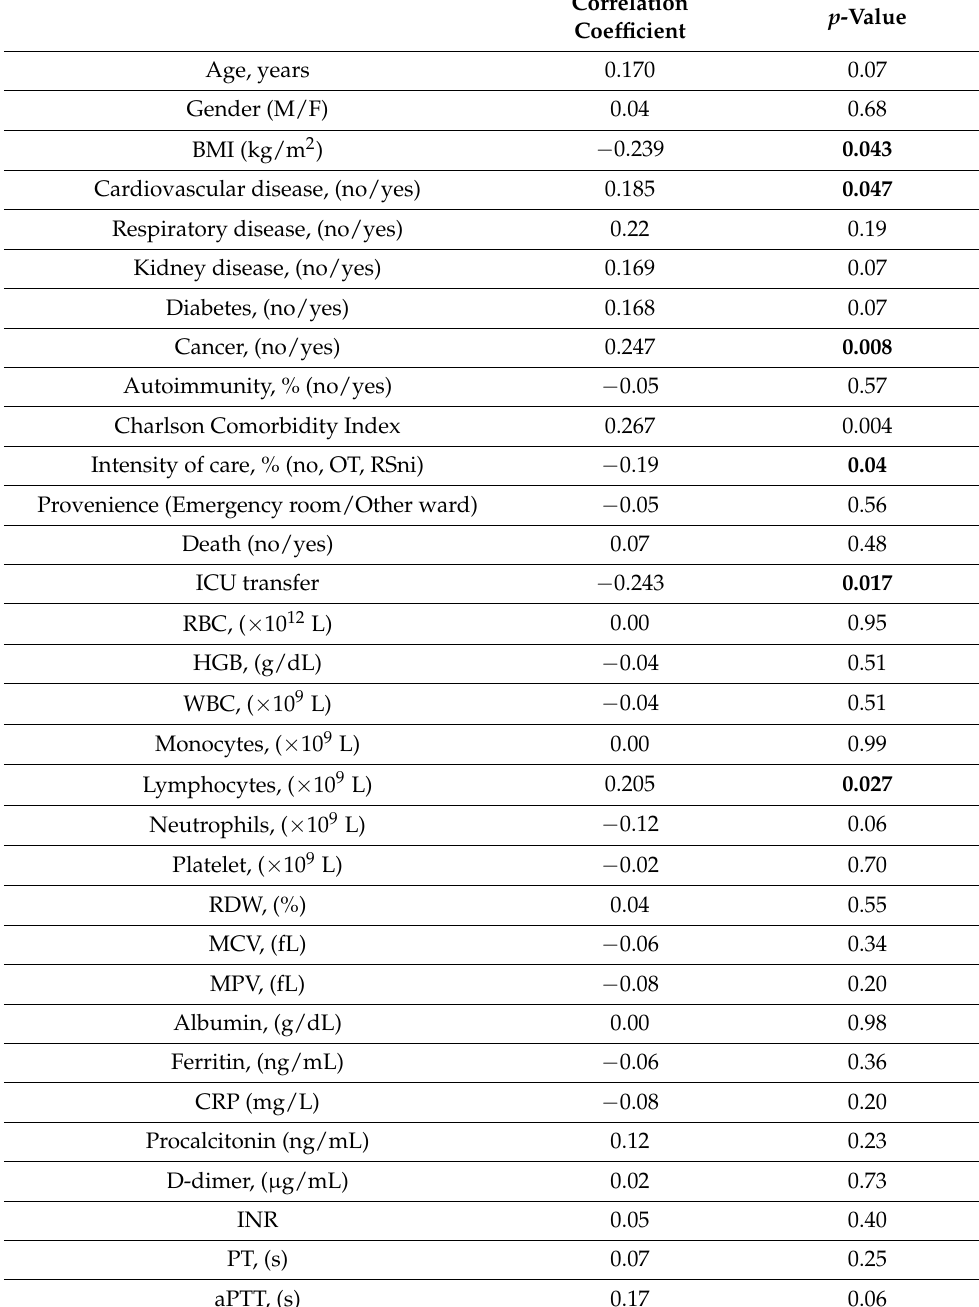
Table 4. Correlations between vaccination status and demographic, clinical, and laboratory character- istics of the studied population on